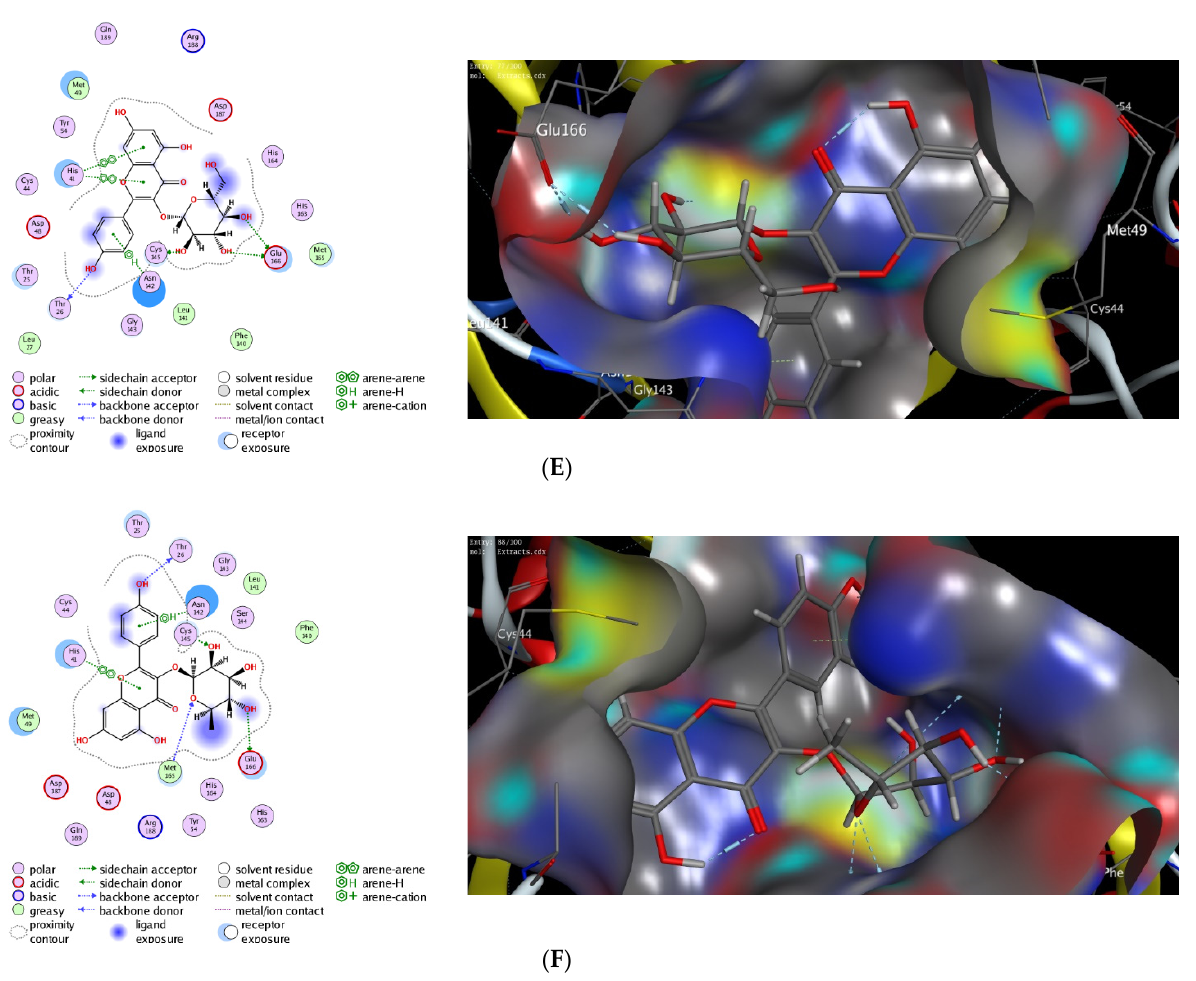
Figure 2. The 2D and 3D molecular docking interactions of Baicalein ( A ), Kaempferol ( B ), Quercetin ( C ), Quercetin 3-O- β -glucoside ( D ), Kaempferol 3-O- β -glucoside ( E ), and Kaempferol 3-O- α -rhamnoside ( F ), (gray in 3D interactions) with 3CL-protease protein (PDB code: 6m2n). The hydrogen bonds are illustrated as dotted blue arrows (C atoms are colored gray, S yellow, and O red). Table 4. Interactions and scores of the docking process of the P. lentiscus bark extract (3–6) in the 3CL-protease binding